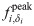
Effects of local excitations on power spectra are more restricted at the high background drive working point (WP3).(A) Schematic of a brain network depicting the stimulated site i in brightest red. The black arrows point to two other regions j and k that lie at progressively further topological distances from the perturbed area in the structural network. In this figure, regions i, j, and k correspond to brain areas 1 (R–Lateral Orbitofrontal), 4 (R–Medial Orbitofrontal), and 10 (R–Precentral), respectively. (B) Left: A segment of region i’s activity time-course in the baseline condition. Right: A segment of region i’s activity time-course when it is stimulated. (C) Power spectra of area i and two other downstream regions j and k. In all three panels, the lighter curves correspond to the baseline condition, and the darker curves correspond to the state in which i is driven with additional input. The gray vertical lines indicate the peak frequency fi,δipeak of region i in the excited condition. (D) Histogram of the shift in peak frequency Δfi,δipeak induced by exciting unit i, plotted over all choices of the perturbed area. (E) The average shift in the peak frequency of the stimulated region 〈Δfi,δipeak〉 for WP1, WP2, and WP3 (error bars indicate the standard deviation over all choices of the excited unit). (F) Distribution of peak frequencies of all units in the baseline condition {fipeak} (light gray) and distribution of the peak frequency units acquire when directly excited {fi,δipeak} (dark gray). (G) Average power spectra 〈psd〉j≠i over all units j ≠ i at baseline (light gray) and when unit i is perturbed with additional input (dark gray). Because stimulation does not induce a well-separated excited frequency band, we only assess perturbation-induced changes in the PLV between brain areas for a single baseline frequency band (purple area).